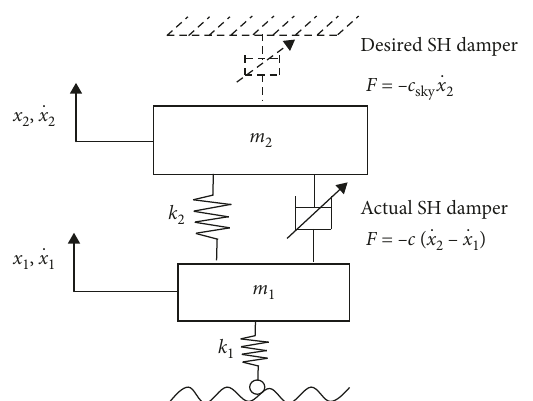
Figure 7: Schematic diagram of desired and actual SH damper system.